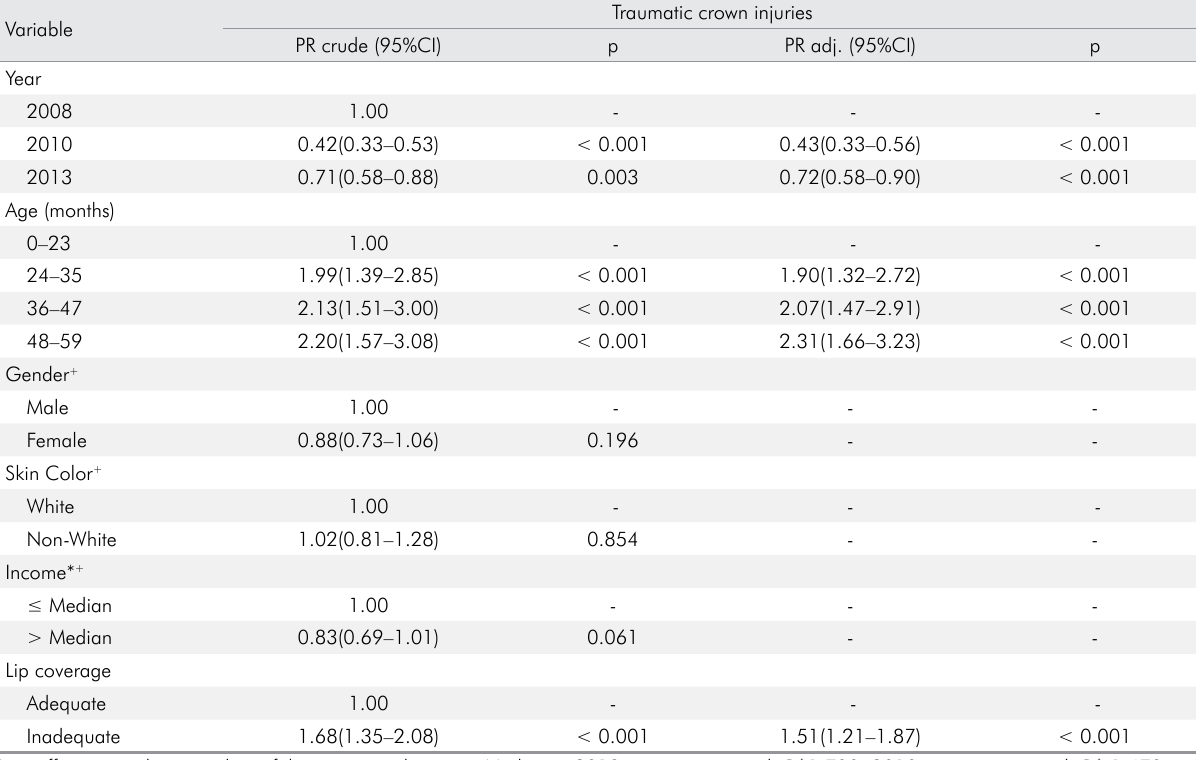
Table 3. Poisson regression of traumatic crown injuries and associated factors. Santa Maria, Brazil.